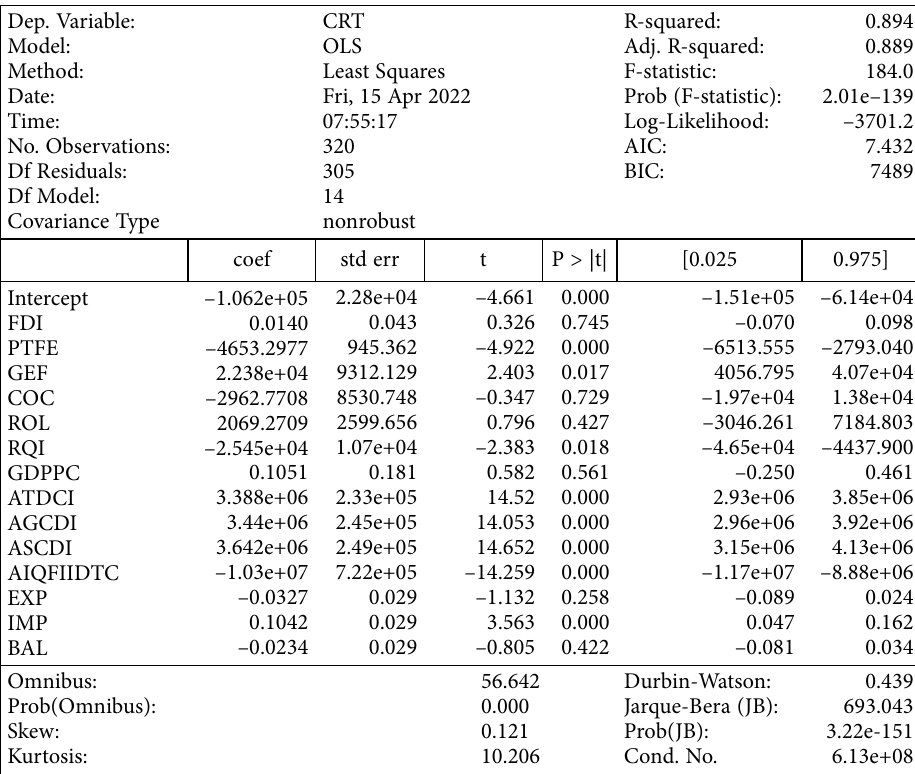
Table 5. OLS regression results – Part 1 (source: own processing using Python 3.0